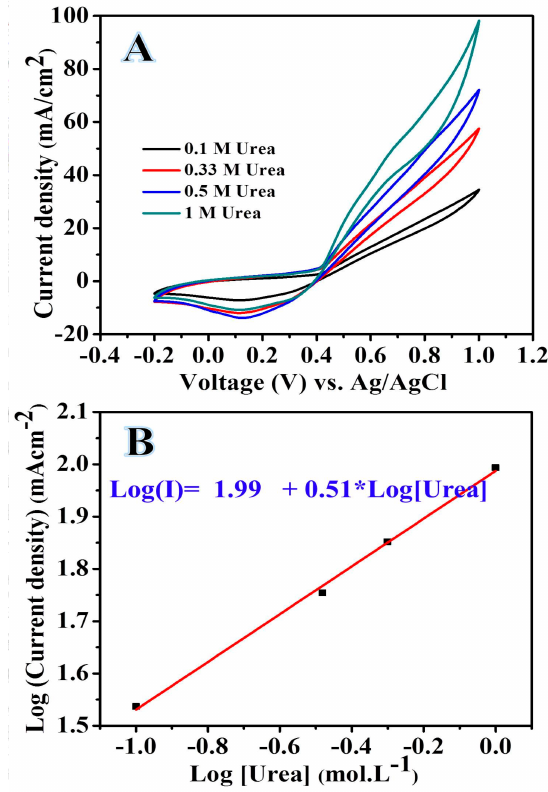
Figure 9. ( A ) Cyclic voltammograms of UO in composite NF anodes in 1 M KOH solution for 50 mV / s containing di ff erent concentrations of urea. ( B ) Double logarithmic variations of CD of UO with urea